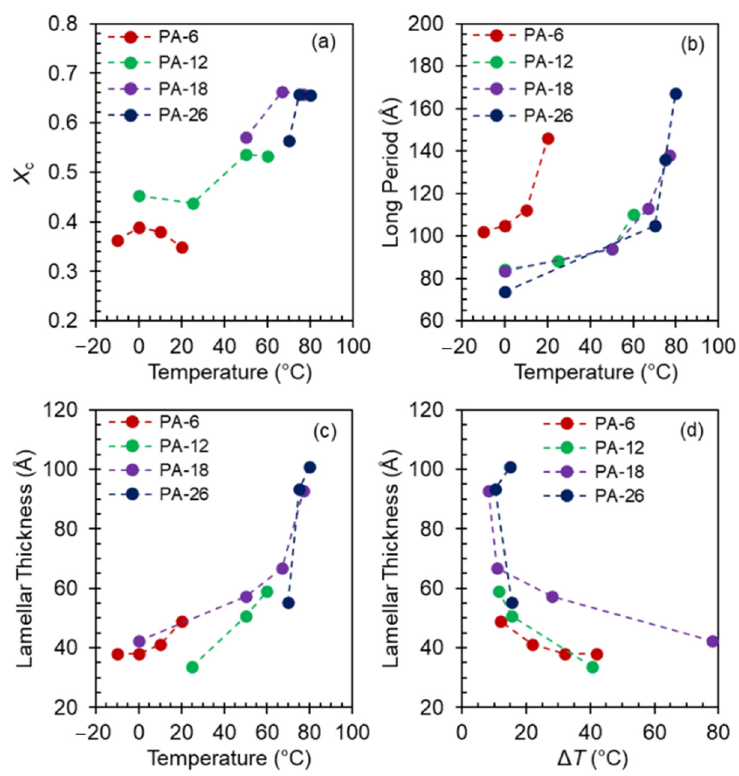
Figure 11. ( a ) Degree of crystallinity ( X c ) from WAXD patterns, ( b ) long period, and ( c ) lamellae thicknesses vs. temperature collected on heating to the indicated temperatures. ( d ) Lamellae thicknesses vs. undercooling ∆ T